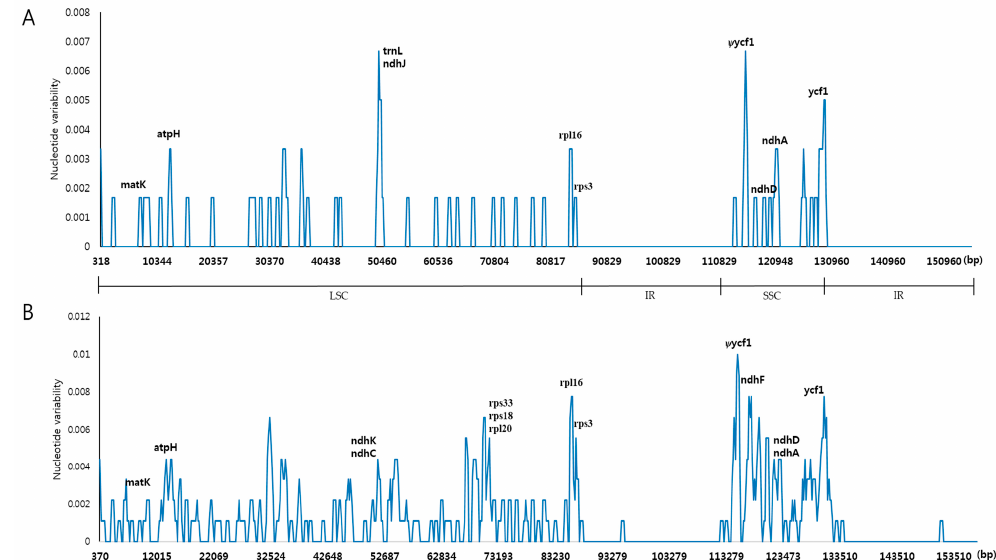
Figure 5. Sliding-window analysis of CP genomes. ( A ) Comparison of the nucleotide variability (Pi) between A. pseudolaeve Nakai and A. longecassidatum Nakai CP genomes; ( B ) Comparison of the nucleotide variability (Pi) among Aconitum subgenus Lycoctonum CP genomes, including A. barbatum Patrin ex Pers., A. pseudolaeve, and A. longecassidatum. CP: chloroplast Molecules 2017 , 22 , 2012